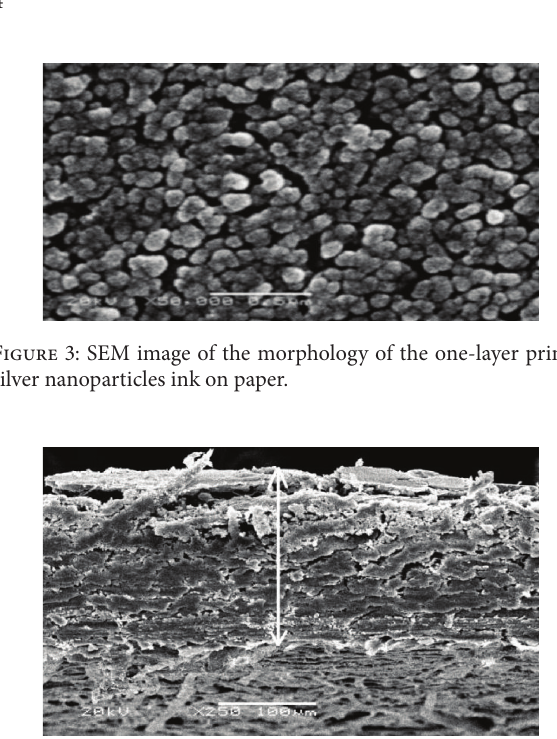
Figure 4: Cross-section image of the one-layer printed nanoan- tenna (the white line presents the printed silver nanoparticles ink and the glossy paper substrate is under the white line).